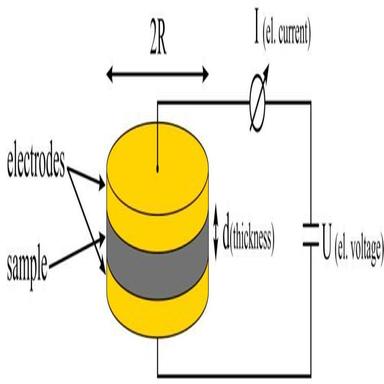
Basic measurement setup for performing dielectric measurements.